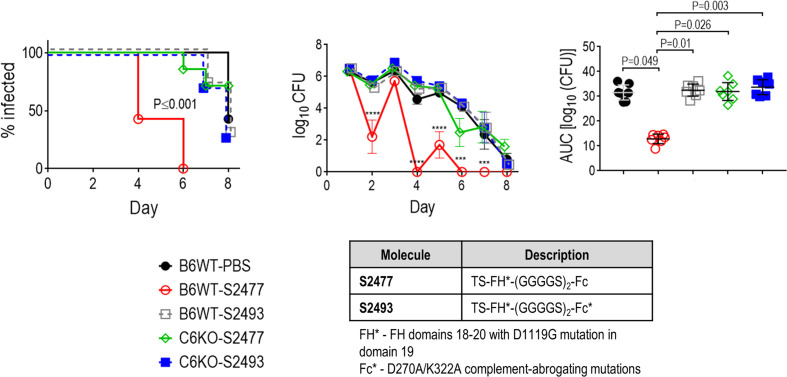
Terminal complement is required for efficacy of FH/Fc against N. gonorrhoeae H041 in vivo. The activities of S2477 (TS-FH*/Fc with (G4S)2 linker) and S2493 (the corresponding FH/Fc molecule with D270A/K322A mutations in Fc that abrogates complement activation) were tested in C6−/− mice or wt C57BL/6 control mice. Mice (n = 7/group) were infected with 4.2 × 106 CFU N. gonorrhoeae H041 and treated daily (starting 2 h before infection) with 5 µg of the indicated FH/Fc protein intravaginally; control animals received PBS. Left graph: Kaplan Meier curves showing time to clearance, analyzed by the Mantel-Cox (log-rank) test. Significance was set at 0.005 (Bonferroni’s correction for comparisons across five groups). Middle graph: log10 CFU versus time. X-axis, day; Y-axis, log10 CFU. Comparisons of the CFU over time between each treatment group and the respective PBS control was made by two-way ANOVA and Dunnett’s multiple comparison test. ***P < 0.001; ****P < 0.0001. Right graph: bacterial burdens consolidated over time (area under the curve [log10 CFU] analysis). The five groups were compared by one-way ANOVA using the non-parametric Kruskal-Wallis equality of populations rank test. The χ2 with ties was 17.15 (P = 0.0018). Pairwise AUC comparisons across groups was made with Dunn’s multiple comparison test.